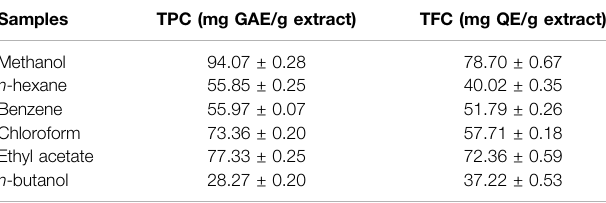
TABLE 1 | Total bioactive contents of S. indicus extracts/fractions. Samples TPC (mg GAE/g extract)